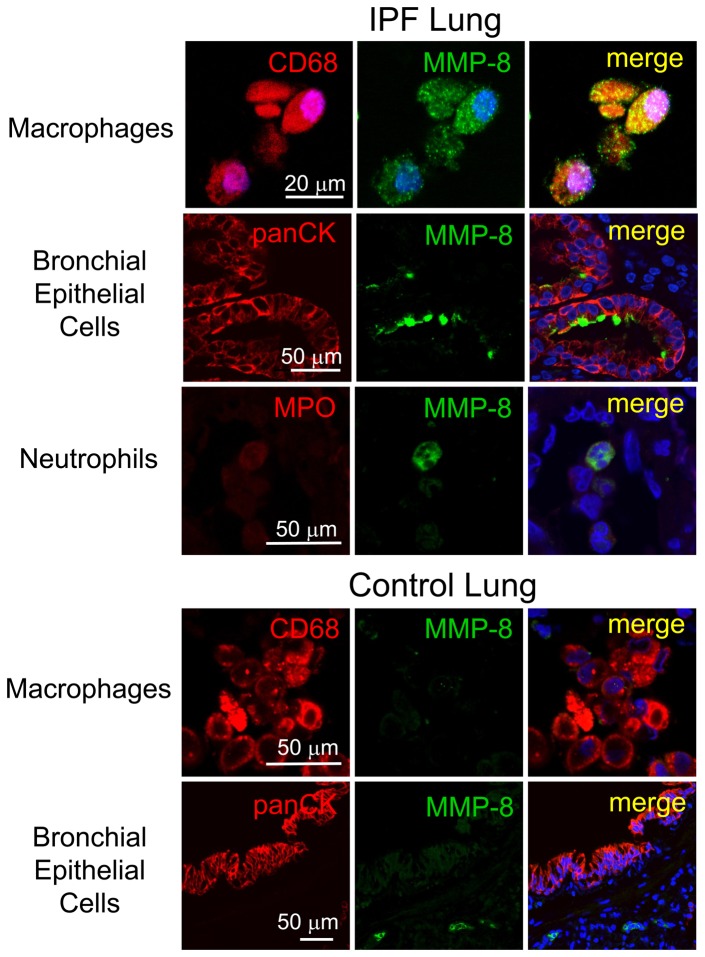
MMP-8 expression is increased in macrophages and bronchial epithelial cells in IPF lungs.Double immunofluorescence staining of an IPF lung section (upper panels) and a control lung section (lower panels) was performed using a red fluorophore (left column) for macrophages (CD68), airway epithelial cells (pancytokeratin; PanCK), or neutrophils (myeloperoxidase; MPO) and with a green fluorophore for MMP-8 (middle column). Lung sections were also stained with isotype-matched non-immune murine and rabbit IgG control antibodies (see Fig. 5). Nuclei were stained with 4′,6-diamidino-2-phenylindole (DAPI), and lung sections were examined using a confocal microscope. Merged images (right column) show co-localization of staining for MMP-8 and CD68 and also for MMP-8 and PanCK in the bronchial epithelium of an area of severe fibrosis in the IPF lung (upper panels). The control lung section (lower panels) shows no staining for MMP-8 in macrophages and minimal staining for MMP-8 (middle column) in bronchial epithelial cells. Images are representative of immuno-stained lung sections from 2 controls and 3 patients with IPF. Magnification is X 600 in both panels.